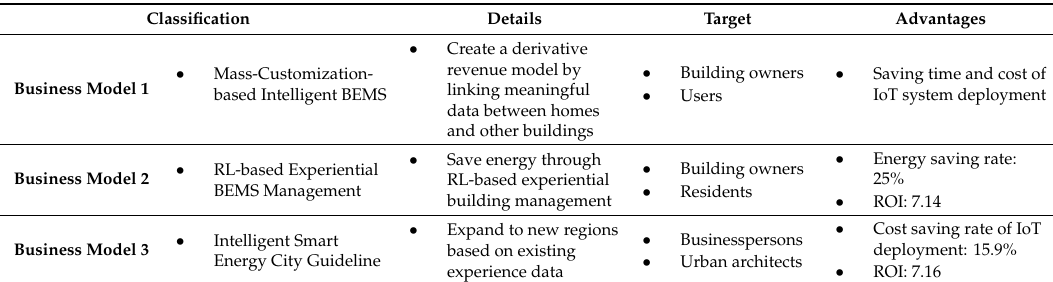
Table 19. Derivative Business